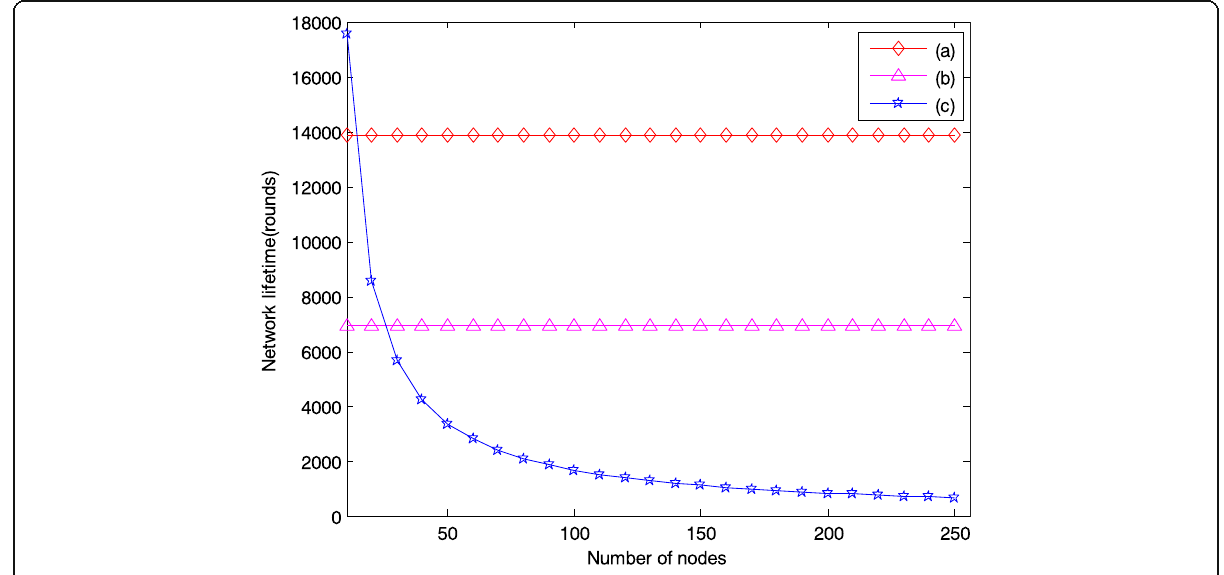
Fig. 13 Comparison of lifetime of network under different data collection